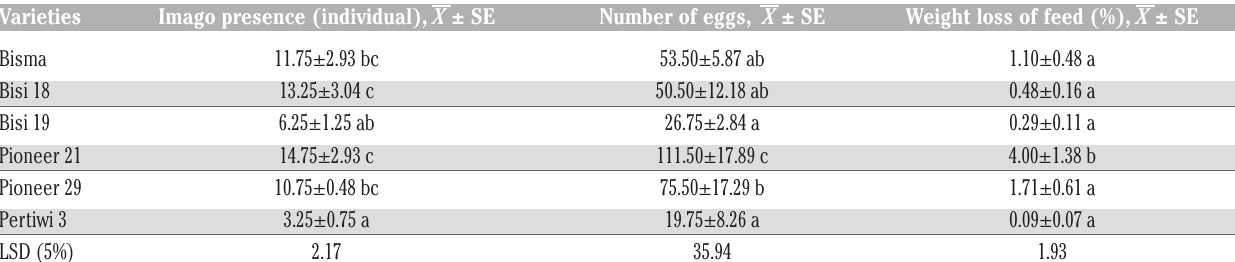
Table 1. Mean value of S. zeamais adult insects presence, eggs, and weight loss of feed (%) due to an S. zeamais infestation using FCTM on the six varieties of tested corn.